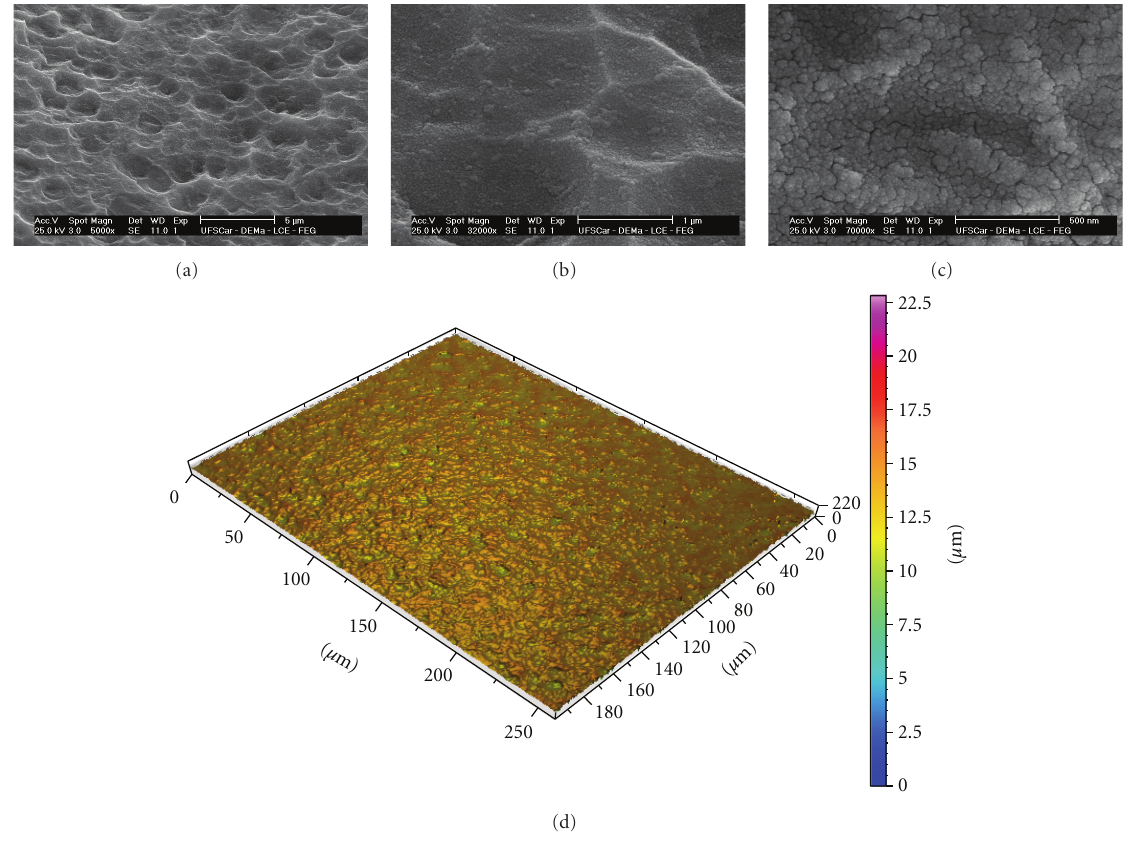
Figure 1: SEM micrographs of nanoroughened implant surface before protein coating (magnification (a) × 5,000, (b) × 32,000, and (c) × 70,000). (d) Interferometer image of nanoroughened implant surface before protein coating (measurement area: 260mm × 200mm).